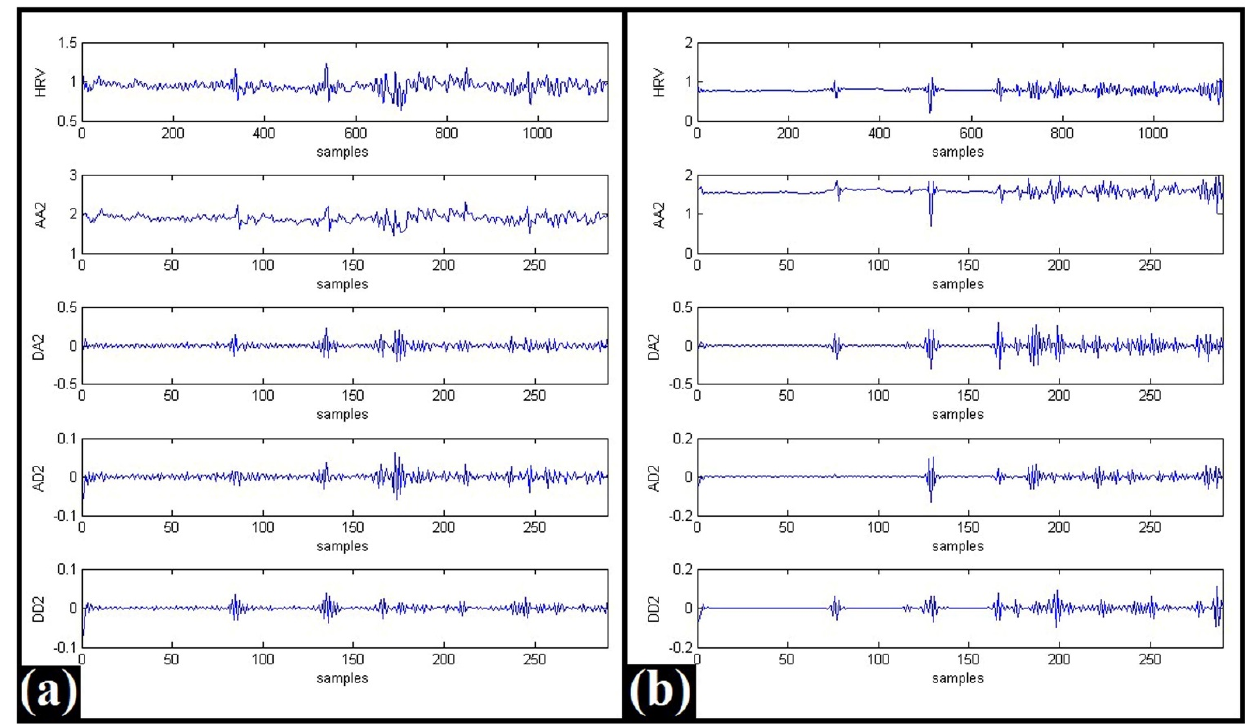
Figure 4. Typical WPD coefficients for db02 mother wavelet-based level 2 decomposition of HRV signals: ( a ) Category-C, and ( b )